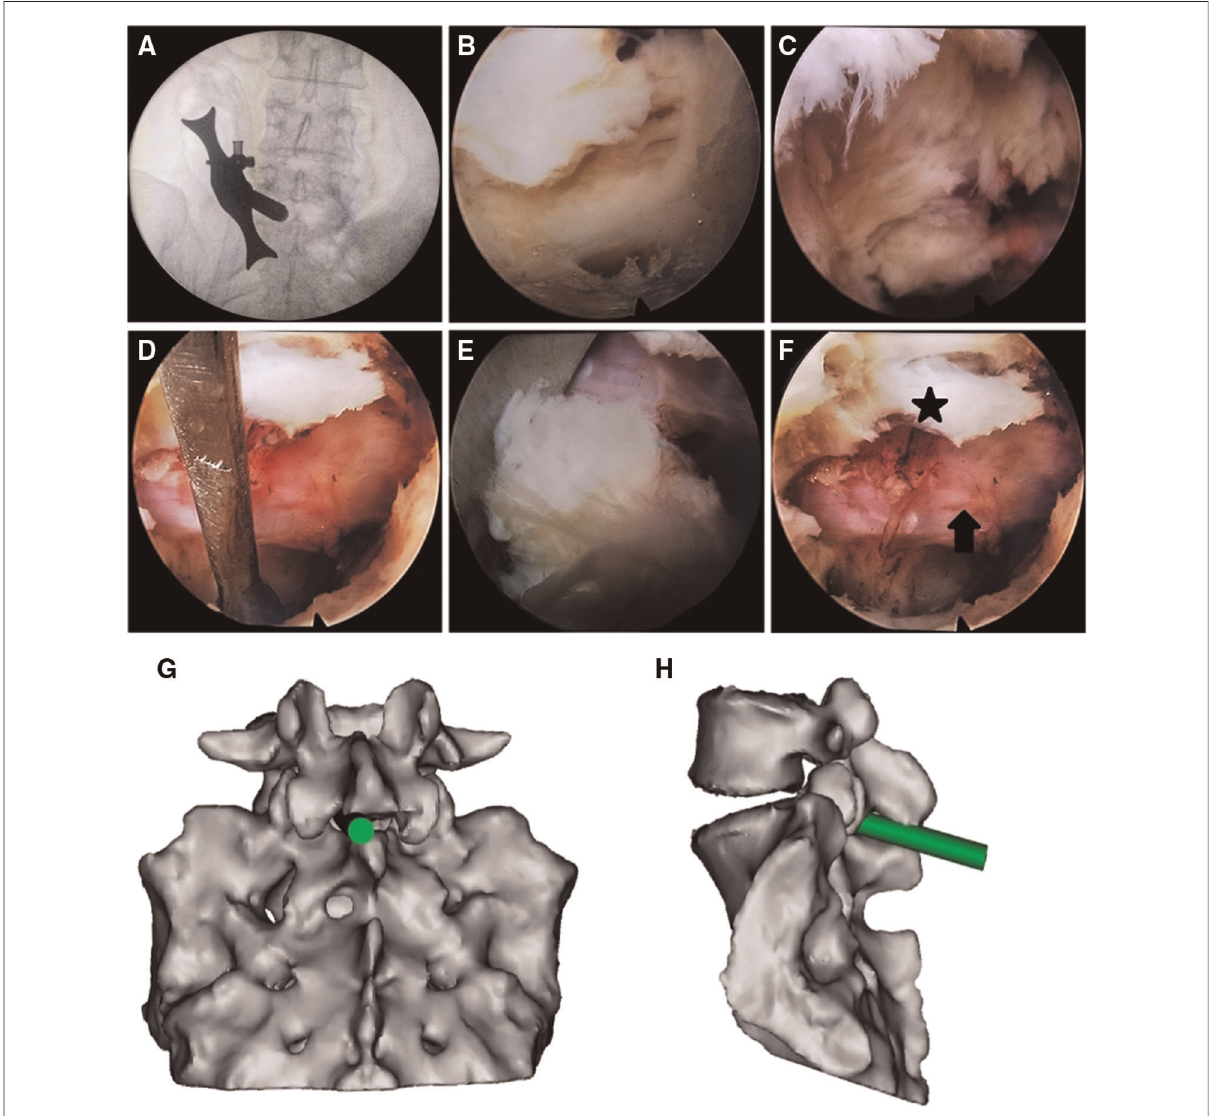
FIGURE 1 Percutaneous endoscopic lumbar discectomy via the interlaminar approach in a 37-year female with L5 – S1 disc herniation. ( A ) The dilator was localized using fl uoroscopy before surgery and placed as close to the ligamentum fl avum as possible. ( B ) The ligamentum fl avum after removing fat and muscle tissue from its surface. ( C ) Exposure of the dural sac and nerve root by opening the ligamentum fl avum. ( D ) Release of the nerve root. ( E ) Herniated nucleus pulposus. ( F ) Intraoperative S1 nerve root (arrow), and the opened ligamentum fl avum (star). ( G,H ) Schematic presentations of the working cannula in frontal ( G ) and side ( H )